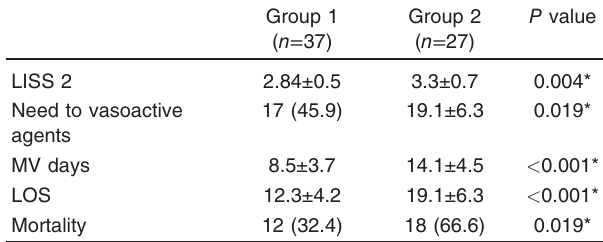
Table 4 Correlation between in-patient mortality and other variables